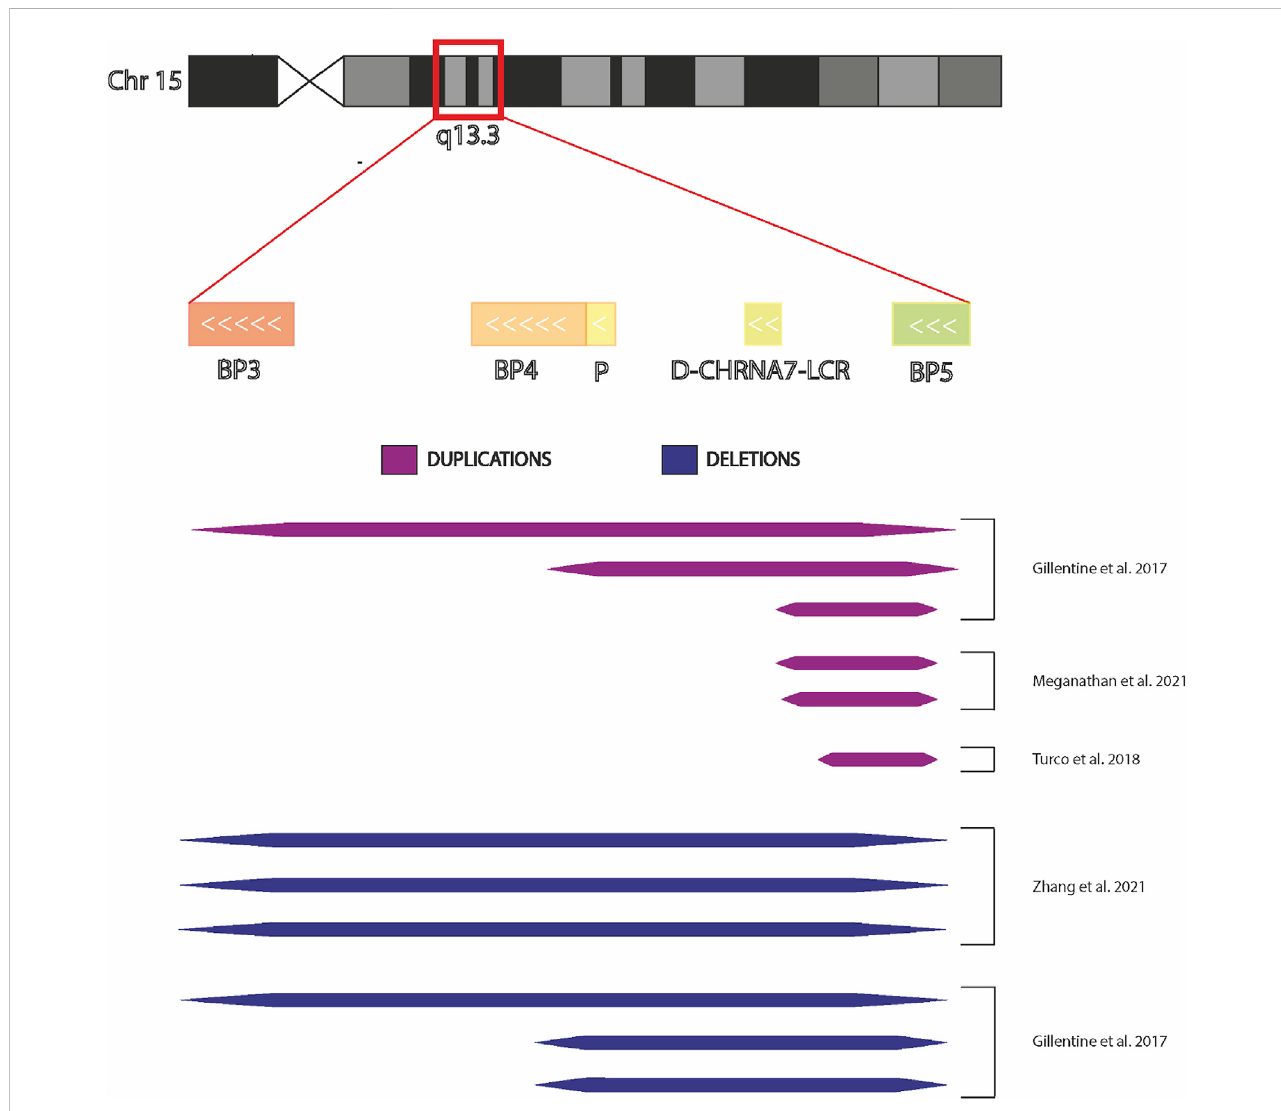
Chromosome 15q13.3 and hiPSCs derived from individuals with CNV. Graphic representation of chromosomal region 15q13.3 showing BreakPoint regions BP3, BP4 and BP5 and the extensions the microdeletions and microduplications present in the hiPSCs in the published